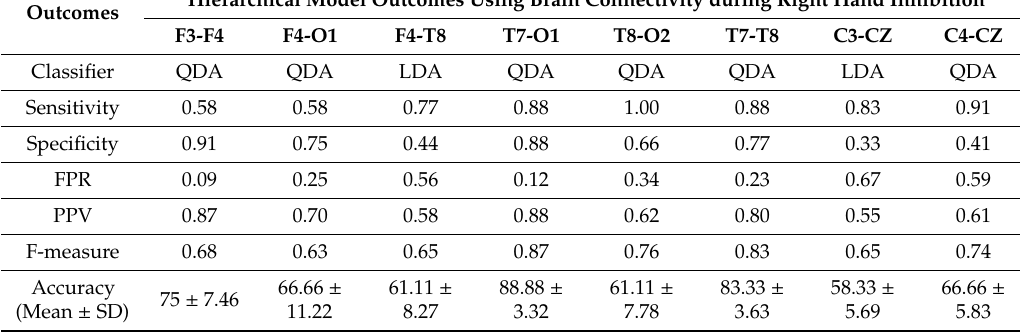
Table 2. Summary of sensitivities, specificities, false positive rate (FPR), positive predictive value (PPV), F-measure and accuracy (%) outcomes during LHR for SS vs. FS.